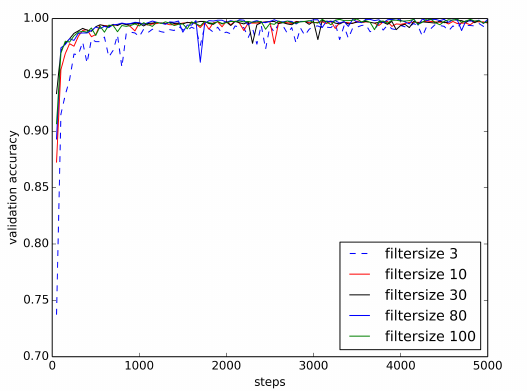
Figure 10. Accuracy Curves of RawConvNet on BUZZ1 Train/Test Dataset. As the size of the receptive field increases, accuracy curves become smoother and increase